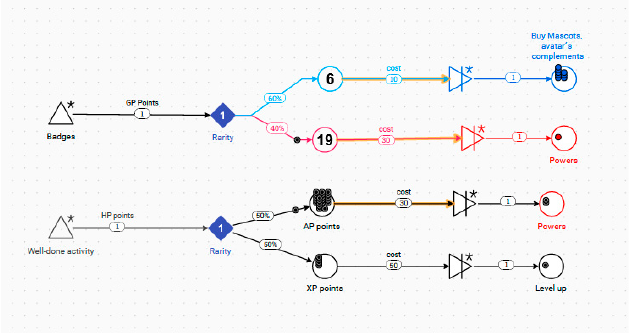
Figure 3. Capture of a moment of the simulation of point acquisition (diagram in “Machinations”, symbols equivalence: triangle=source; circle=pool; triangle with line = converter; rhombus=gate). Leader boards are established as students gain points in cooperative teams and by the whole group in a class, as shown in Figure 4 (see Section 3.1 for more